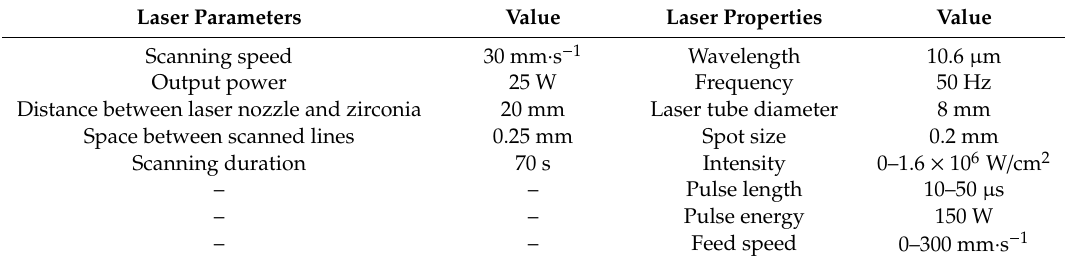
Table 4. Laser (CO 2 laser) scanning parameters and properties.